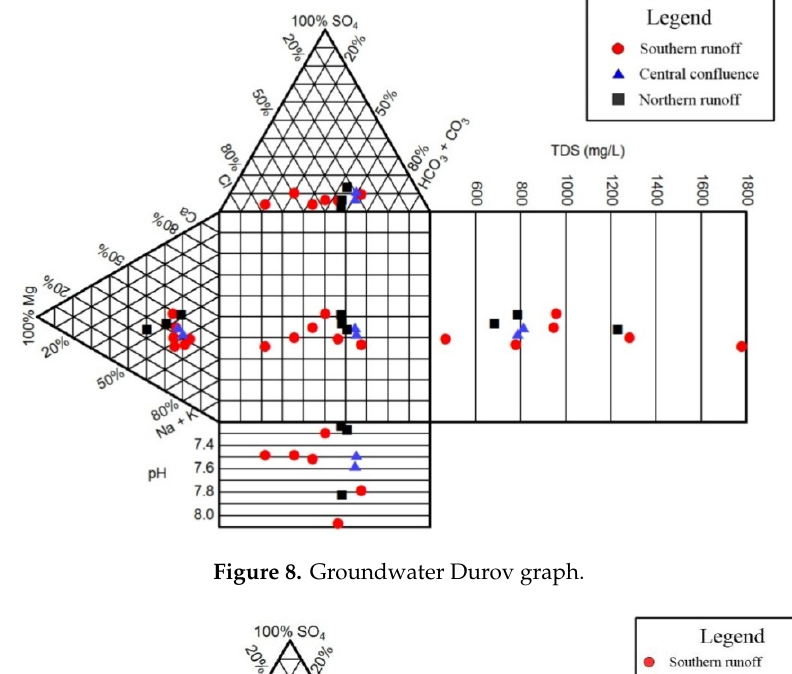
Figure 8. Groundwater Durov graph.